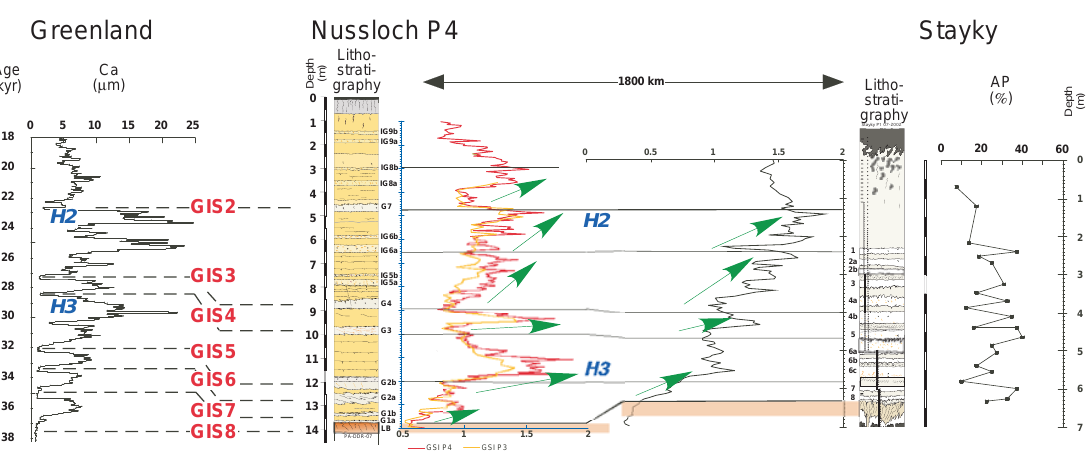
Fig. 7. Comparison between the grain size index (GSI) records in Nussloch (P3 and P4 sequences) (after Rousseau et al., 2007) and in Stayky (this study). Identification of similar cycles (marked by the green arrows), and proposed correlation between the two continental records, supported by IRSL dates, and pollen characteristics (arboreal pollen – AP- percentages) of the embryonic soils. Correlation between the Greenland GRIP dust record (Johnsen et al., 2001) and the Nussloch record according to Rousseau et al. (2007), with GIS 8 correlated with the Nussloch L¨ohner Boden (LB) following Fig. 9. H3 and H2 correspond to marine Heinrich events 3 and 2 in the Greenland and European records. G1-7 and IG5-9 are the identified gleys or oxidized horizons in